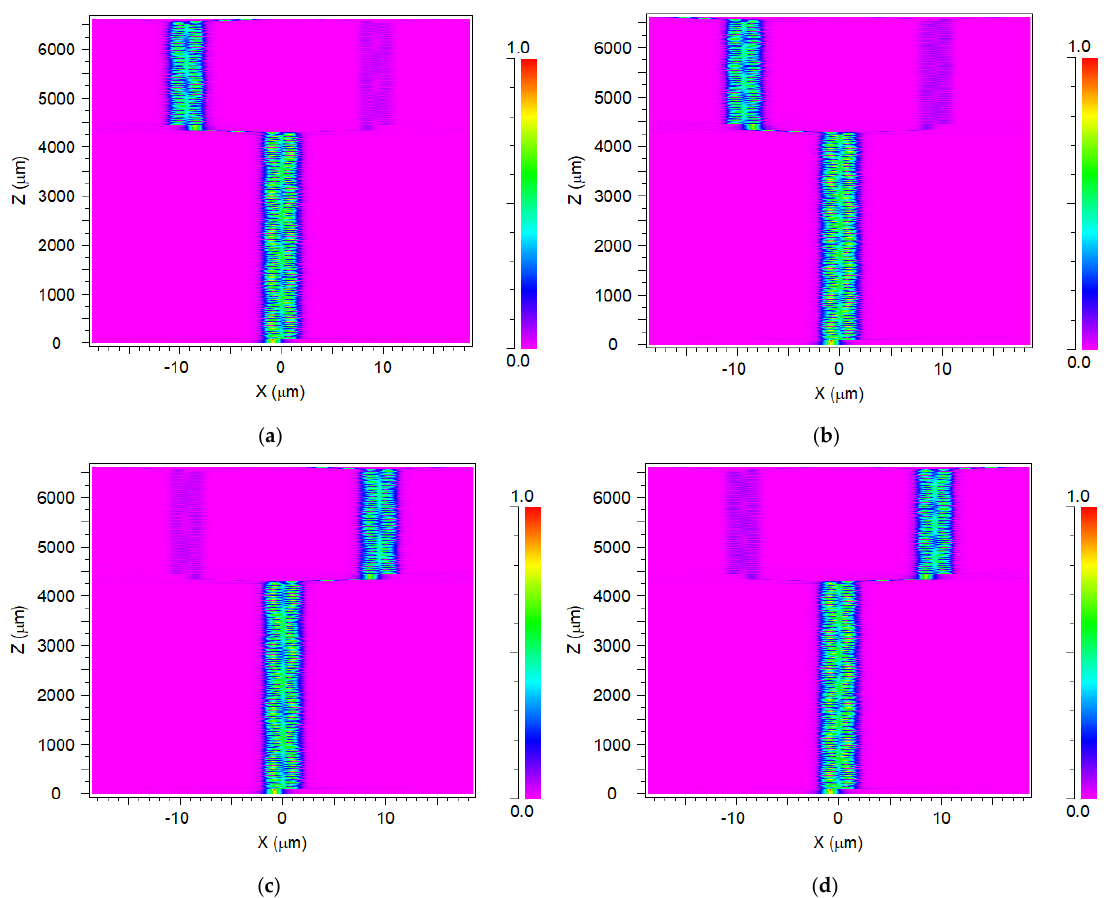
Figure 6. Intensity distributions of the 1 × 4 SiN MMI demultiplexer: ( a ) λ 4 = 1560 nm (port 1), ( b ) λ 2 = 1540 nm (port 2), ( c ) λ 1 = 1530 nm (port 3), and ( d ) λ 3 = 1550 nm (port 4).